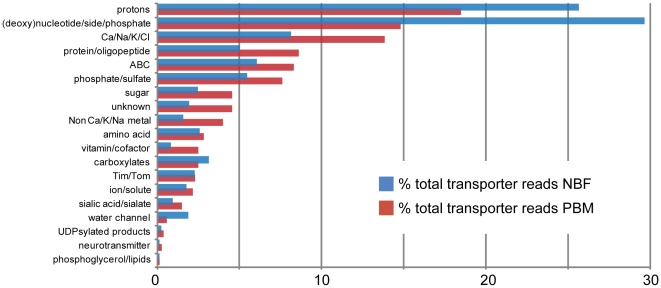
Transporters identified in the Aedes aegypti fat body.Number of reads in the NBF and PBM samples by transporter type. Transporters were identified as described in the text and the number of reads aligned were pulled from the aligned reads generated for our EST expression in the fat body overview.